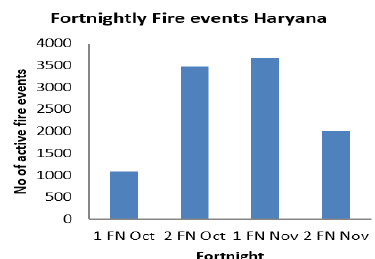
Figure 5b. Fortnightly comparison of active fire events